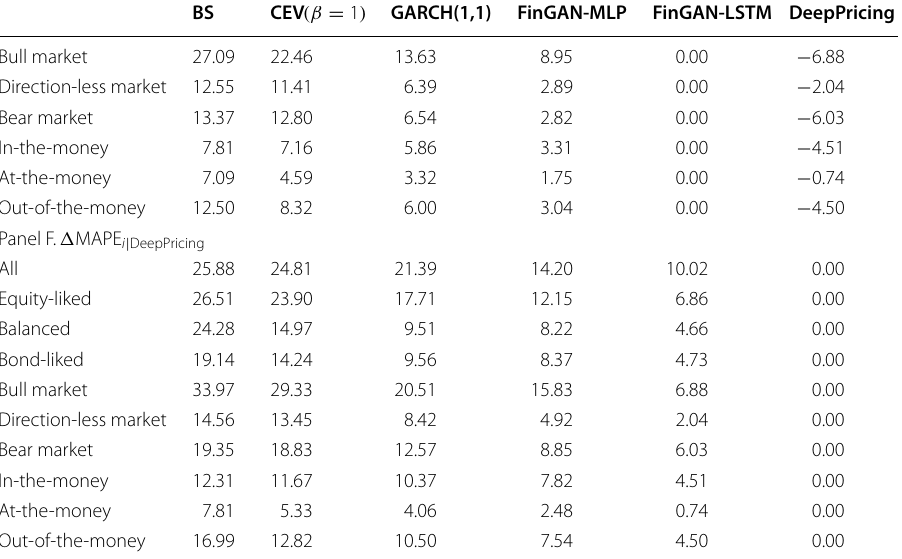
Table 4 shows the MAPE performance metrics across the different models. The metric MAPE i stands for the percentage error of a model i as given by Eq. 43. The metric (cid:31) MAPE i j measures the pricing performance difference of a model i relative to | a model j , which is defined by Eq. 44. The debt‑liked convertible bonds, the balanced convertible bonds and the equity‑ liked convertible bonds is determined by the sensitivity of the convertible bond value to its underlying common stock and defined as (cid:31) (Eq. 23) belongingness to the intervals [0, 0.33]; [0.33, 0.66]; and [0.66, 1], respectively. Market states is classified by bull market including subperiod from January 01, 2014 to June 12, 2015 and subperiod from January 01, 2019 to June 30, 2021, bear market including subperiod from January 01, 2010 to December 31, 2013; subperiod from June 15, 2015 to January 29, 2016; subperiod from January 01, 2018 to December 31, 2018 and direction‑less market (including subperiod S t / K t , where K t is the conversion price and from February 01, 2016 to December 31, 2017. Moneyness is defined as the ξ = S t is the close price of underlying stock. A convertible bond is said to be out‑of‑the‑money if its ξ < 0.99 ; at the money if ξ 0.99,1.01 ; in‑the‑money if ξ > 1.01 . The sample period is from January 01, 2010 through June 30, 2021 and includes ∈ [ ] 125,306